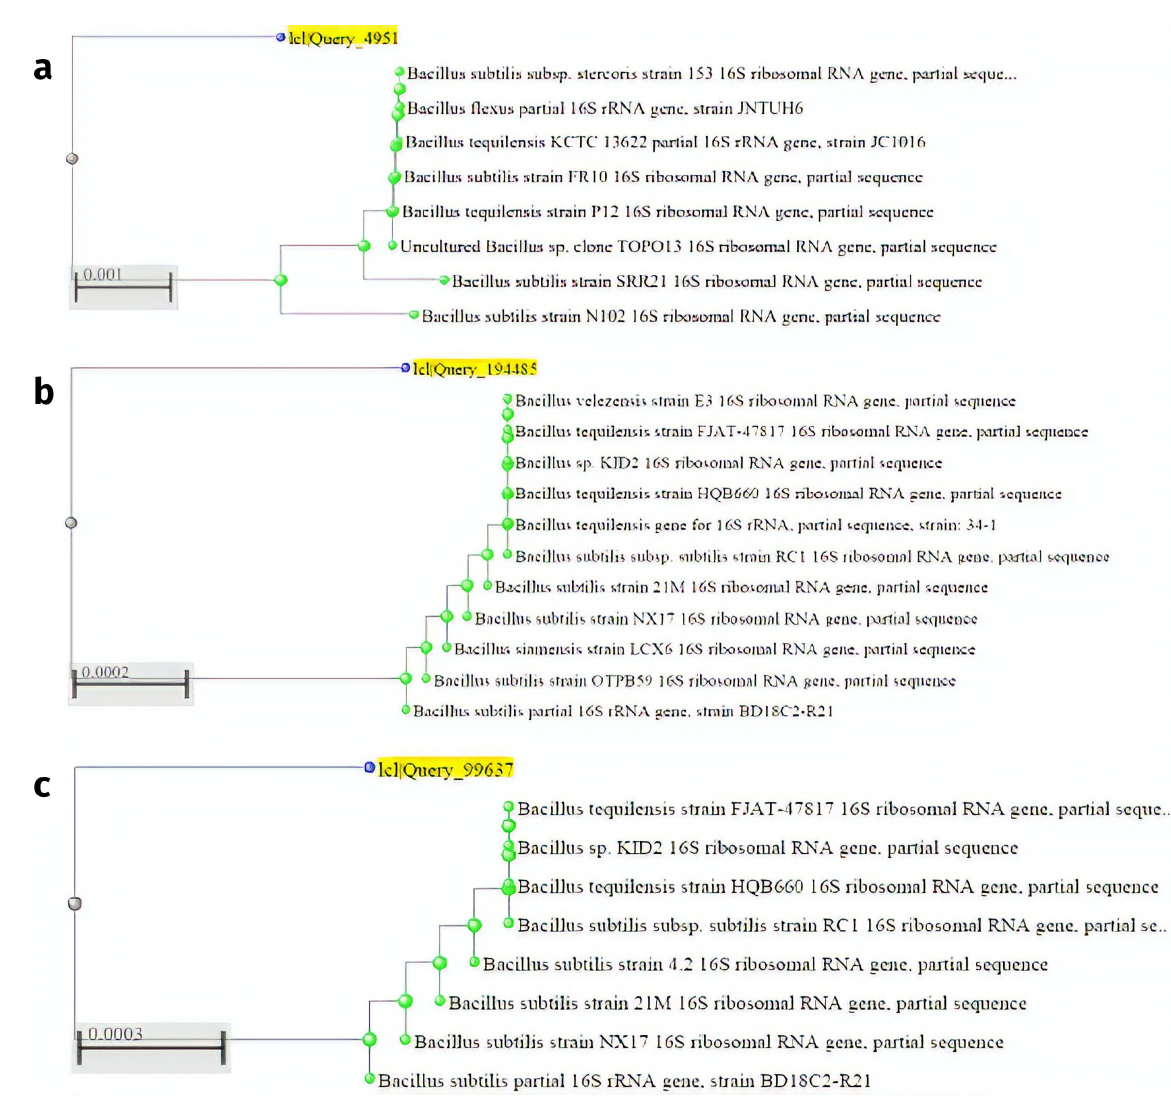
Figure 3. Phylogenetic trees for Bacillus sp. MK1 (a), MK2 (b), and MK3 (c) based on sequence analyses of their 16S rDNA